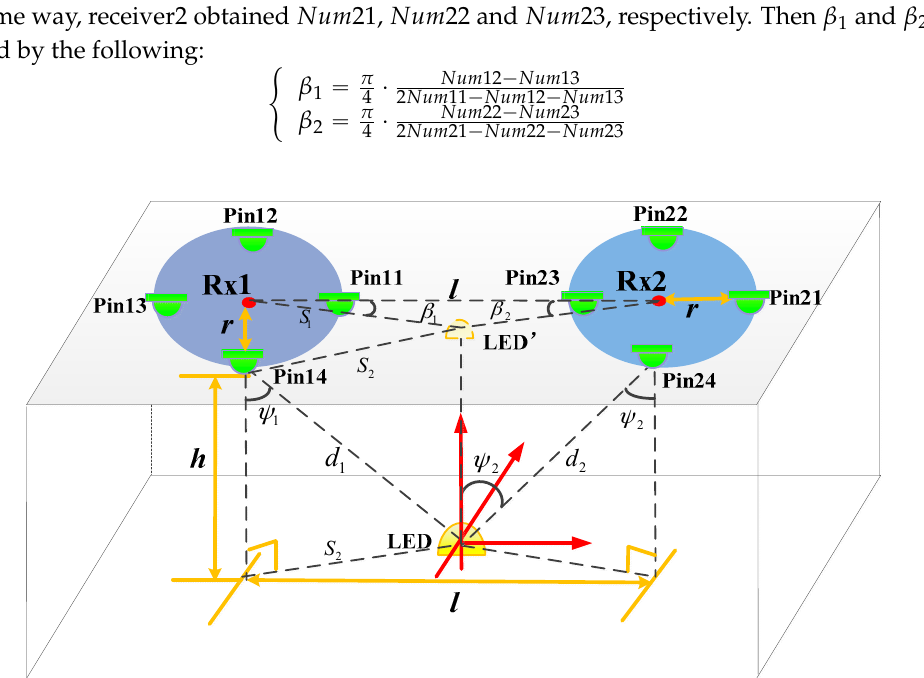
Figure 1. Schematic of VLC indoor positioning system.